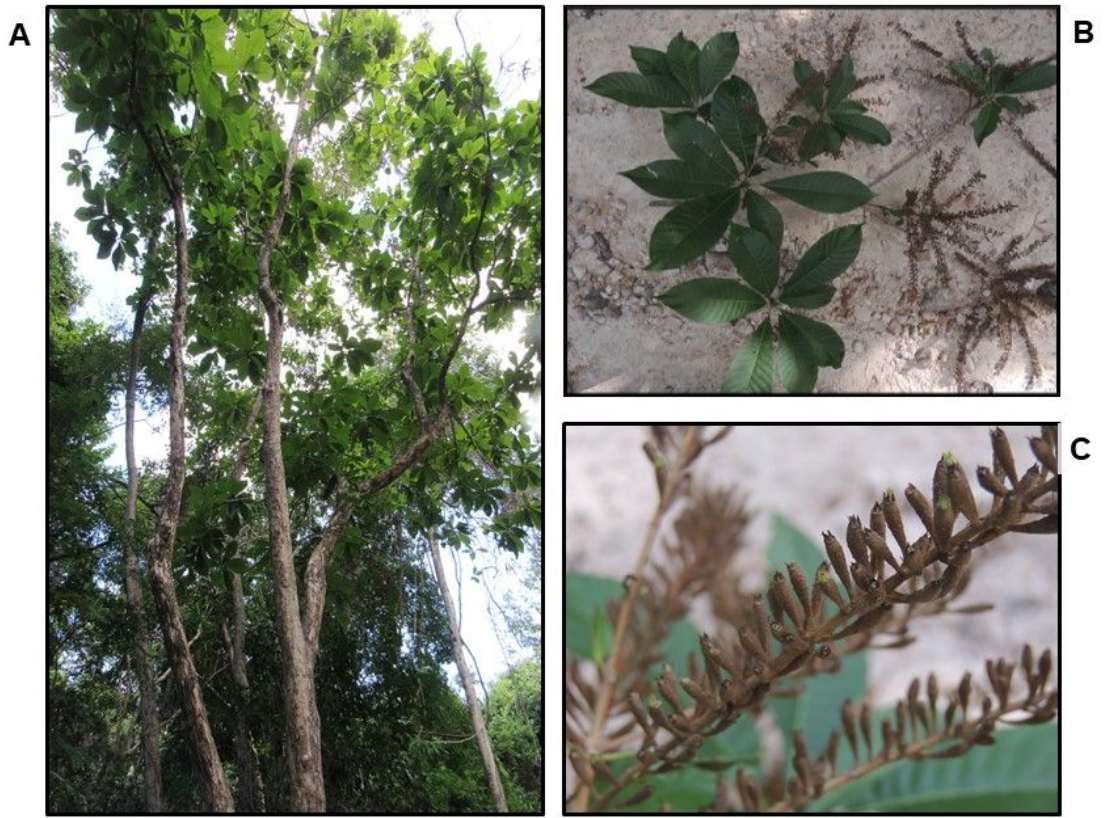
Figure 1. Alseis yucatanensis : ( A ) tree; ( B ) leaves; ( C ) inflorescence.